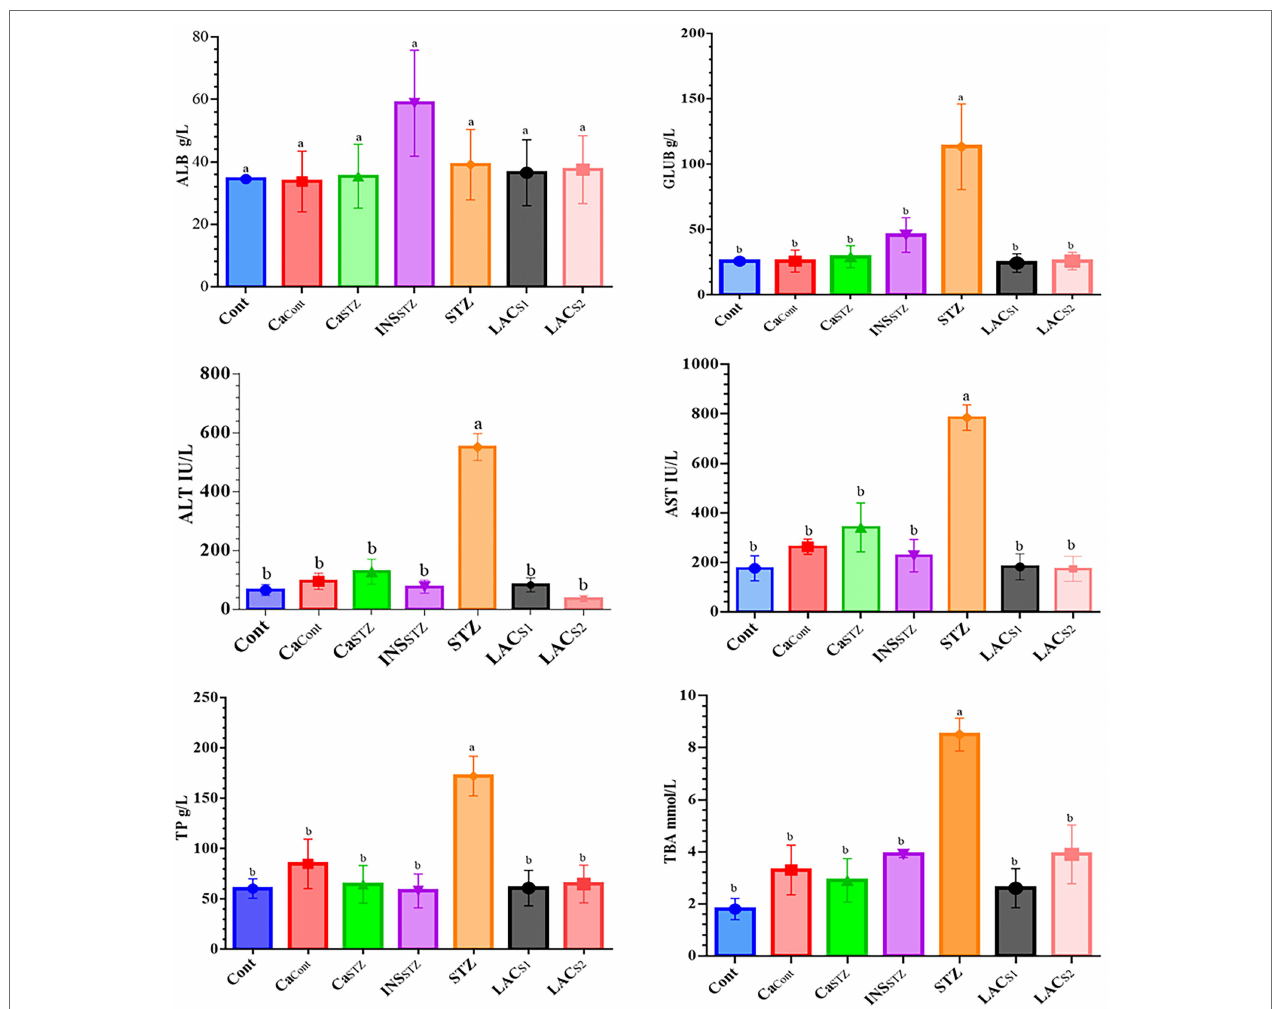
FIGURE 5 | Assessment of liver functions. Cont , control; Ca Cont , camel milk control; Ca STZ , camel milk with streptozotocin; INS STZ , insulin with streptozotocin; STZ , streptozotocin; LAC SI , KLDS 1.0727 with streptozotocin; LAC S2 , KLDS 1.0373 with streptozotocin. Result are given in triplicate as mean ± SD. Different letters indicate significant differences among groups ( p < 0.05). ALB, albumin; GLUB, globulin; ALT, serum alanine aminotransferase; AST, aspartate transaminase; TP, total protein; TBA, total bile